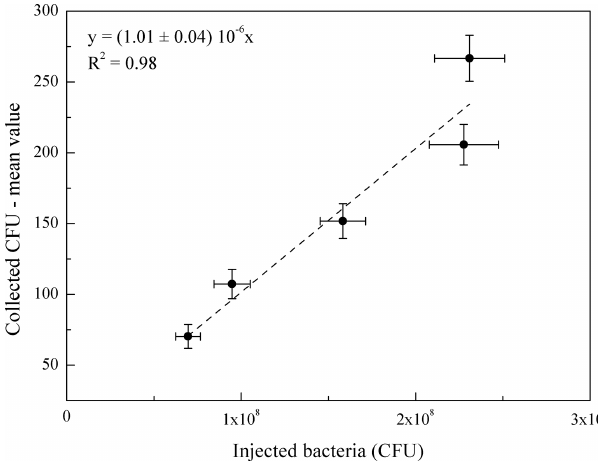
Figure 7. Correlation curve between the number of E. coli bacte- ria injected in ChAMBRe by the SLAG nebulizer and the average count on the four petri dishes exposed in each experiment. The in- jected bacteria correspond to the product of the concentration (i.e., CFUmL − 1 ) in the bacterial suspension for the volume of liquid (2mL) introduced in the nebulizer.